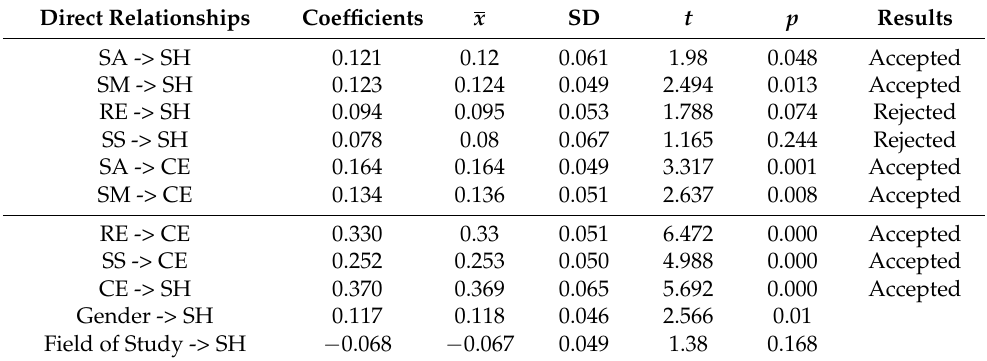
Table 7. Direct relationships.